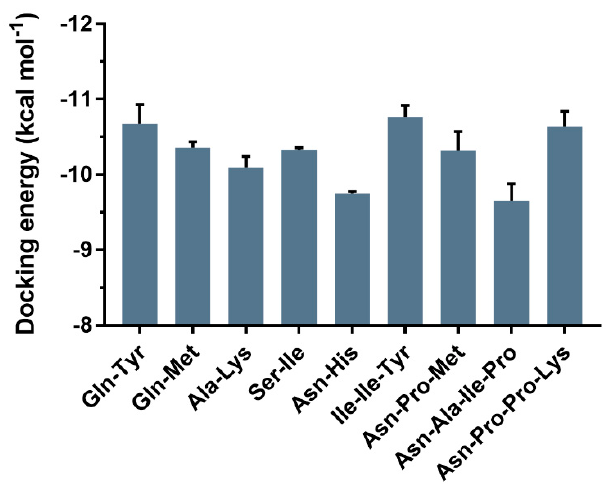
Figure 6. Docking energy of nine new ACE inhibitory peptides from Todarodes pacificus . Docking was performed according to the following parameters: maximum number of generations of 2.7 × 10 4 , rate of gene mutation of 0.02, rate of crossover of 0.8, maximum number of energy evaluations of 2.5 × 10 6 , number of genetic algorithms of 25.